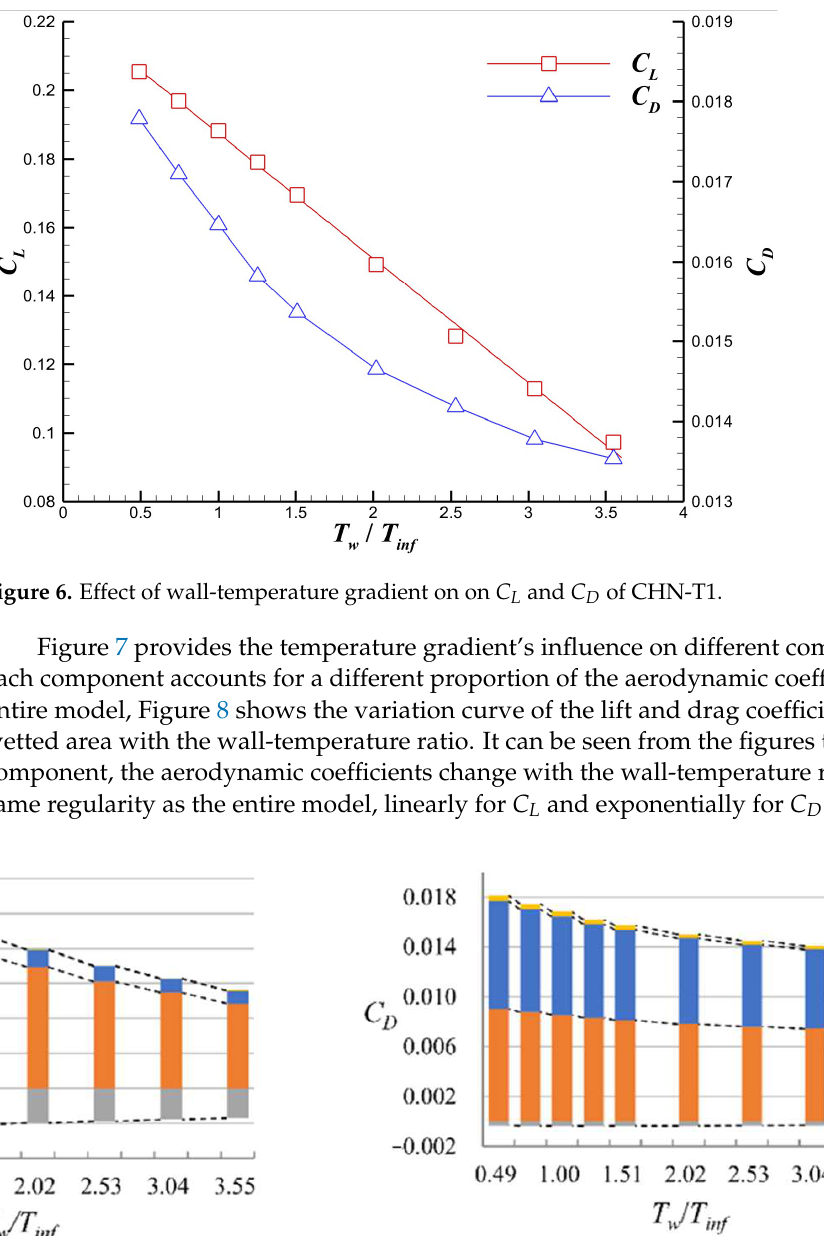
( b ) Figure 8. Effect of wall-temperature gradient on C L * and C D * of each component. ( a ) C L* – T w / T inf ; ( b ) C D* – T w / T inf . The temperature dependences of some physical properties should be discussed prior to further analysis. The skin friction coefficient C f is defined as: 2 0.5 f